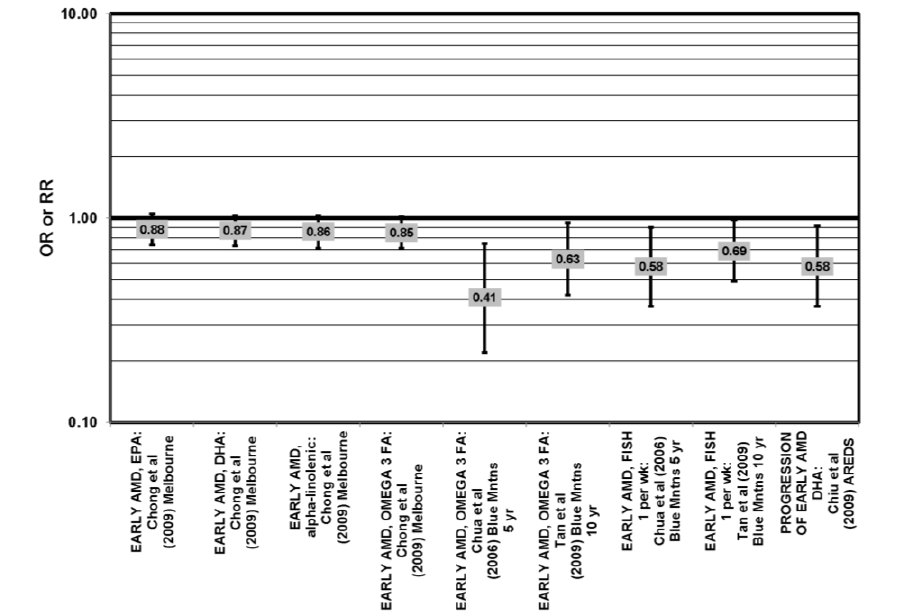
Figure 8. Odds or risk ratio for early AMD or progression to early AMD; high vs. low intake of omega-3 fatty acids: prospective studies.